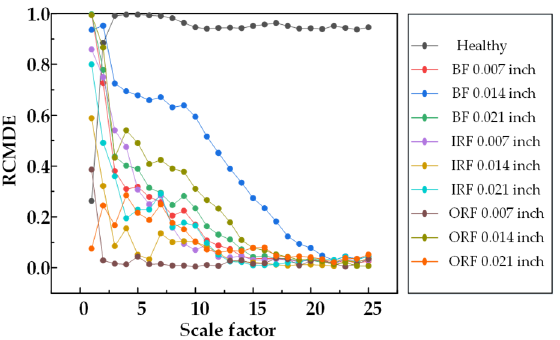
Figure 5. RCMFE entropy values of 25 scale factors under different damage degrees.